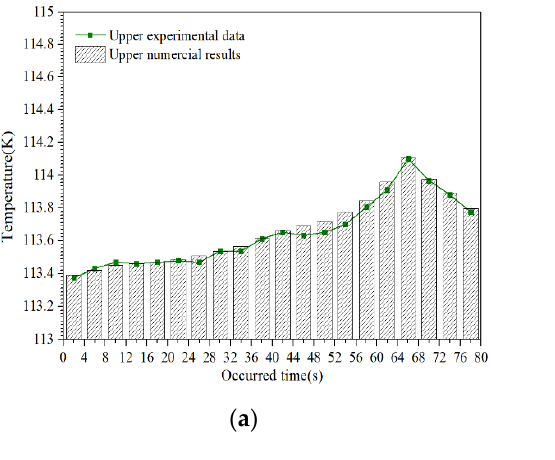
Figure 5. Comparison between the numerical results and experimental data. ( a ) Upper layer; ( b ) lower layer. This figure is adapted from [31] .